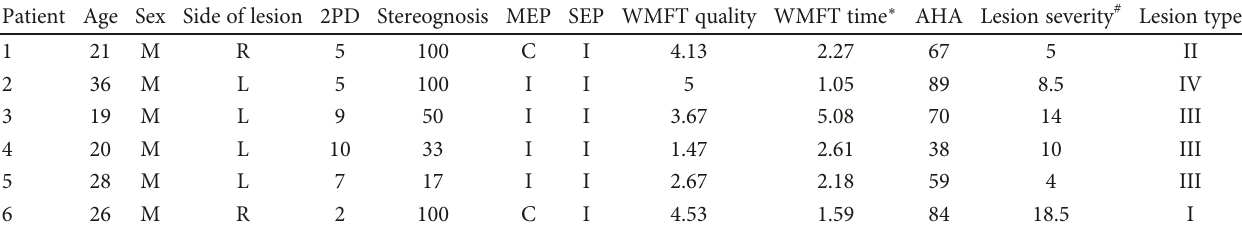
Table 1: Characteristics of subjects with